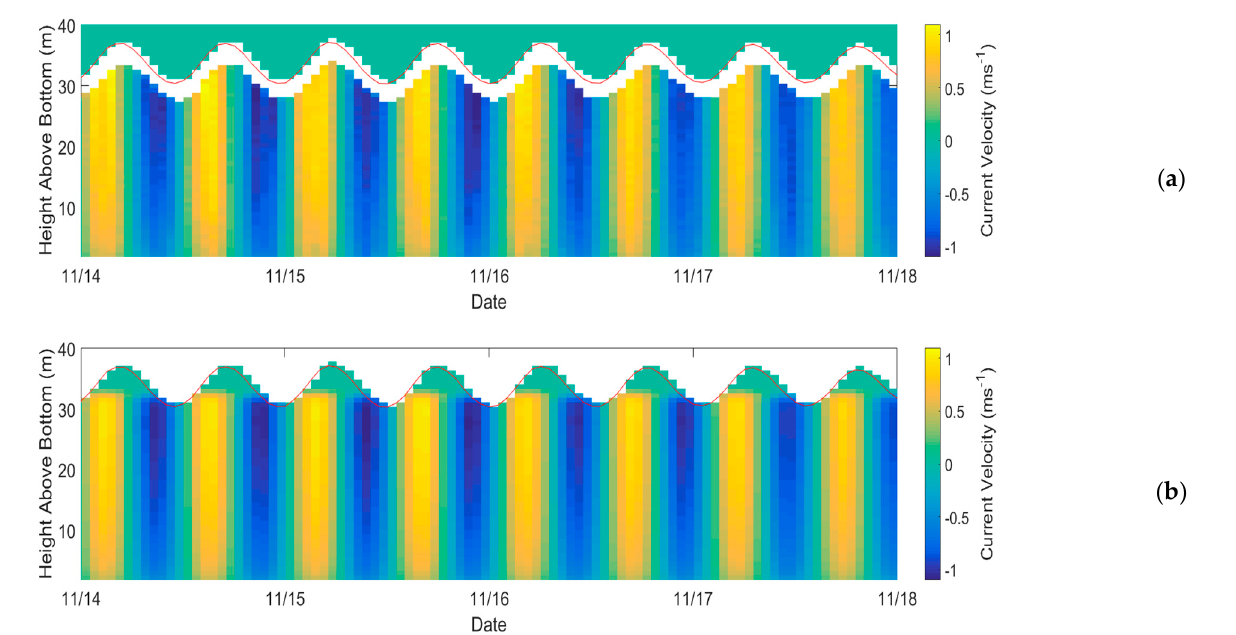
Figure 5. ( a ) Enhanced comparison of measured velocity variation. ( b ) Network predicted velocity variation. Red line = water depth. White space below red line is the location of the inaccurate ADCP data.